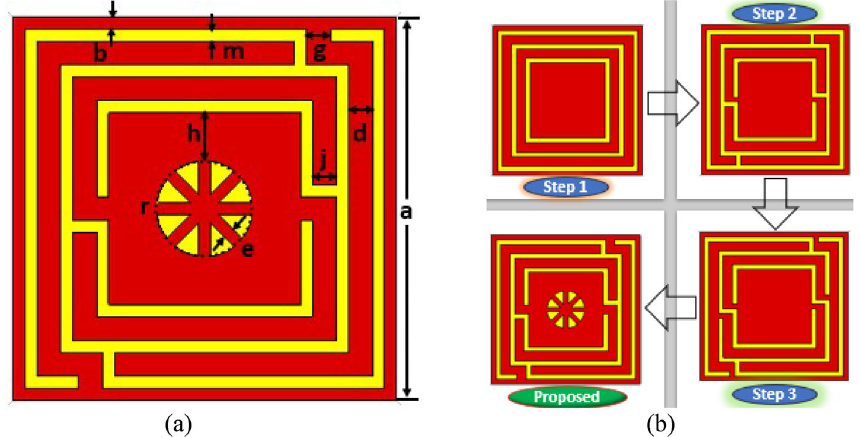
Figure 1. ( a ) The detailed unit cell patch structure with dimension. ( b ) Design evaluation of the proposed MM structure (CST STUDIO SUITE 2019, https:// www. 3ds. com/ produ cts- servi ces/ simul ia/ produ cts/ cst- studio- suite) 39 .